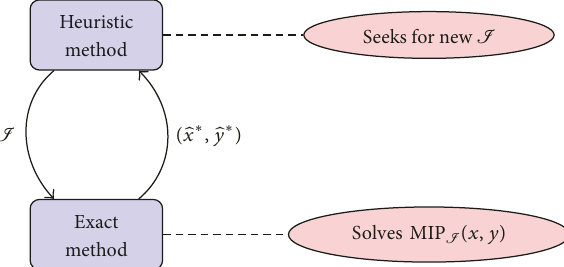
Figure 1: Interaction between a heuristic method and an exact